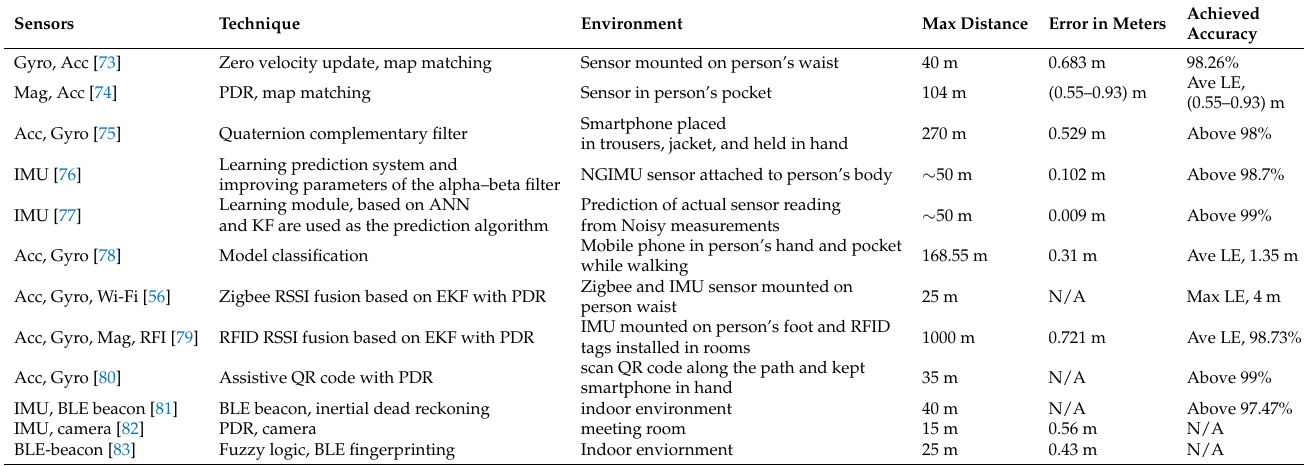
Table 1. Critical analysis of existing technologies for positioning error in